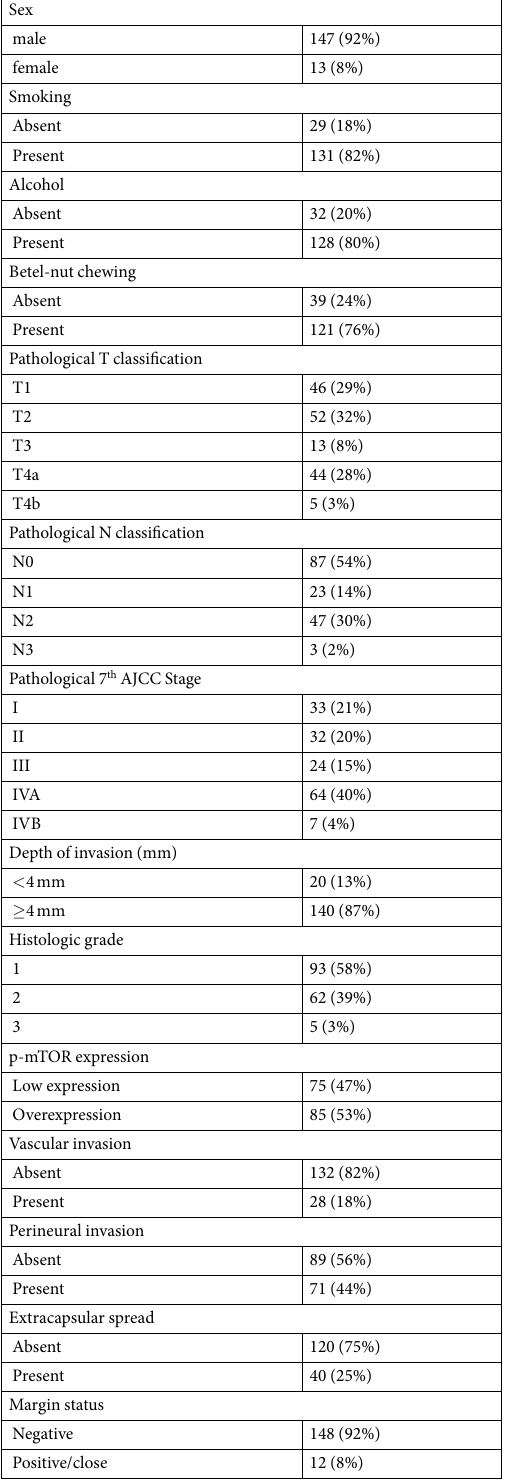
Table 1. Characteristics of 160 patients with tongue squamous cell carcinoma. Abbreviation: p-mTOR, phosphorylated mammalian target of